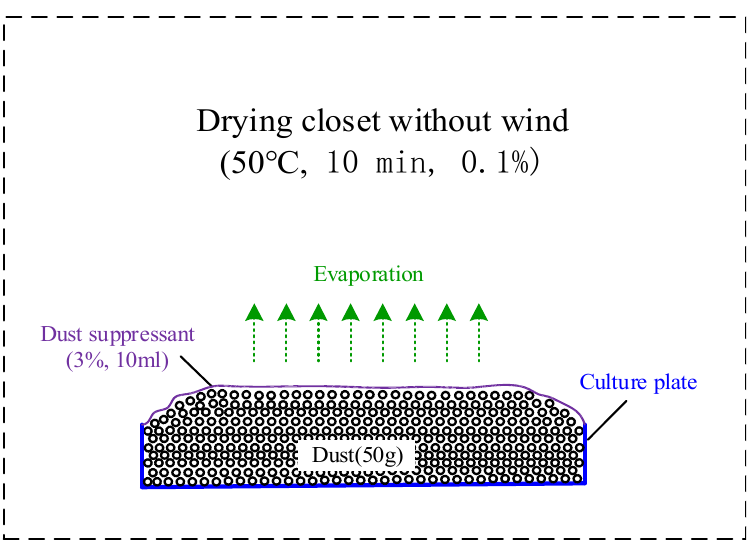
Figure 3. Schematic diagram of the stabilization time experiment. 3. Surface wind erosion rate: (a) The dry 50-g quartz dust samples are naturally stacked in a φ 100-mm glass surface dish, and the dust surface is gently scraped. (b) Then, 10 mL of the test solution with a mass concentration of 3% is evenly dropped on the surface of the test dust pile. The initial mass m 0 is weighed and recorded after 10 min. (c) The test dust sample surface plate is placed in a stable flow field (wind speed 4 m/s) and fixed horizontally. The final mass m 1 is weighed and recorded after 20 min of placement in the flow field. (d) The surface wind erosion rate is